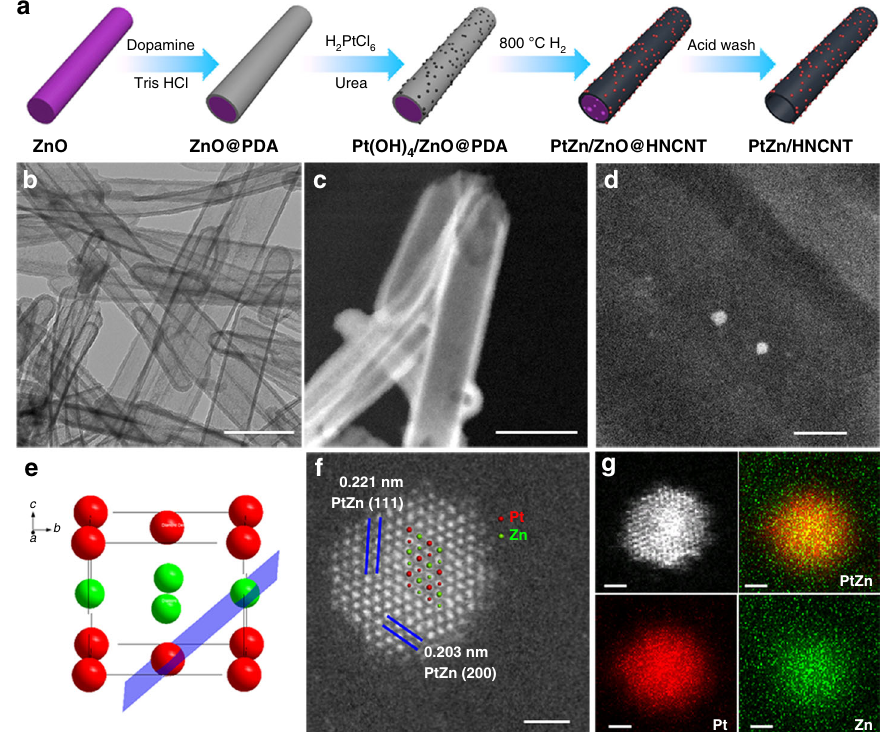
Fig. 1 Synthetic scheme and characterization of the catalyst. a Synthetic strategy of PtZn intermetallic nanoparticles supported on hollow nitrogen-doped carbon nanotubes (PtZn/HNCNT). b – d , Transmission electron microscope (TEM) ( b ), high angel annular dark fi eld scanning TEM (HAADF STEM) ( c ), and aberration-corrected (AC) HAADF STEM ( d ) images of PtZn/HNCNT. Scale bar, 500 nm ( b ); 200 nm ( c ); 10 nm ( d ). e Crystal structure of PtZn intermetallic compound (IMC) (Pt: red; Zn: green). f , g AC HAADF STEM ( f ) image and elemental mappings ( g ) of a PtZn IMC nanoparticle. Scale